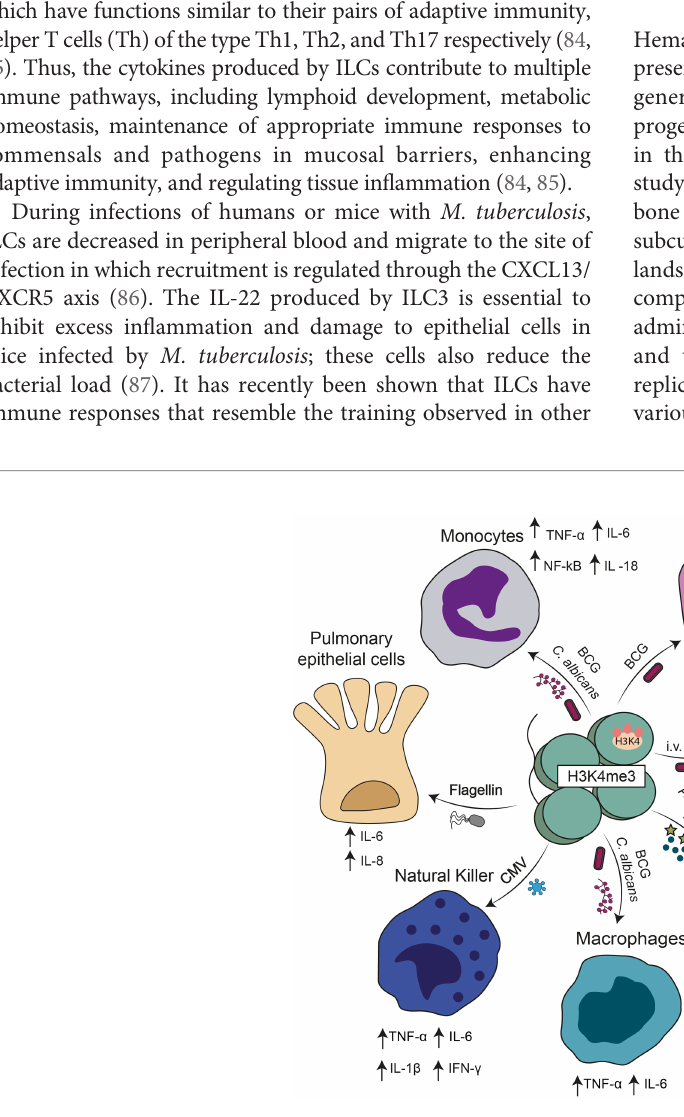
FIGURE 1 | Cell subsets in which trained immunity has been described. Different stimuli including BCG, b -glucan, cytokines, CMV, and bacterial components can induce a trained immunity phenotype. A common hallmark of trained immunity in these cases is the presence of H3K4me3 in the promoters of genes encoding for different cytokines described in the fi